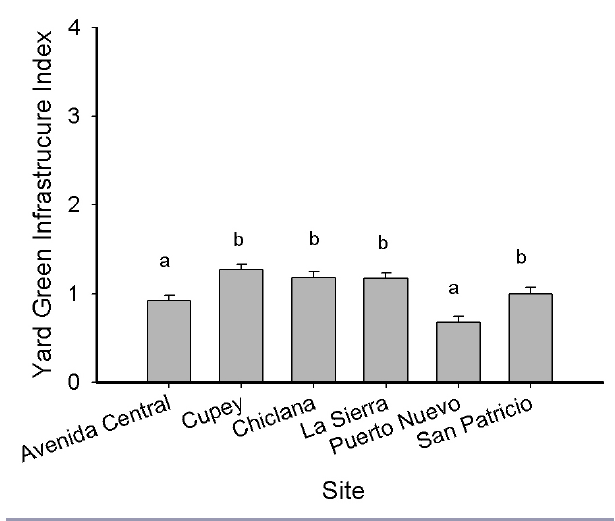
Fig. 4 . Differences in average yard green infrastructure (YGI) index across sites within the Río Piedras Watershed. One-way ANOVA results were F5, 386 = 12.5, p < 0.001. Bars represent standard errors around the site means and different letters denote significant differences at the p = 0.05 level using Tukey’s post-hoc